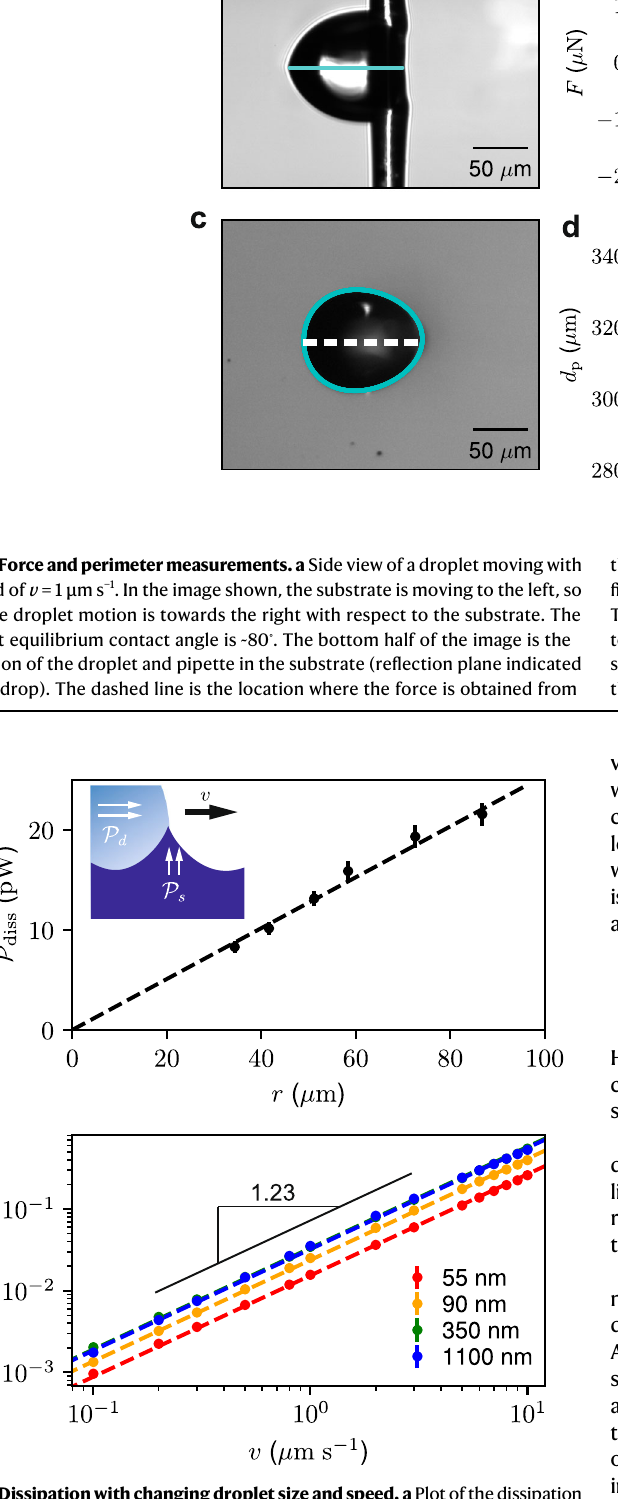
Fig.3|Dissipationwithchangingdropletsizeandspeed.a Plotofthedissipation as a function of the droplet radius for a droplet moving at v =10 μ ms − 1 on a sub- strate with h =(34±1)nm. We calculate radius from a top view perimeter contour ( r ≡ d p /2 π ,where d p isthedropletperimeter)Inset:schematicofdissipationsources asridgemoves. b Plotofdissipationperunitlengthvsdropletspeedforseveral fi lm thicknesses. Each curve includes speeds from 0.1 μ ms − 1 to 10 μ ms − 1 . Error barsfor both panels are calculated using standard deviations for triplicate